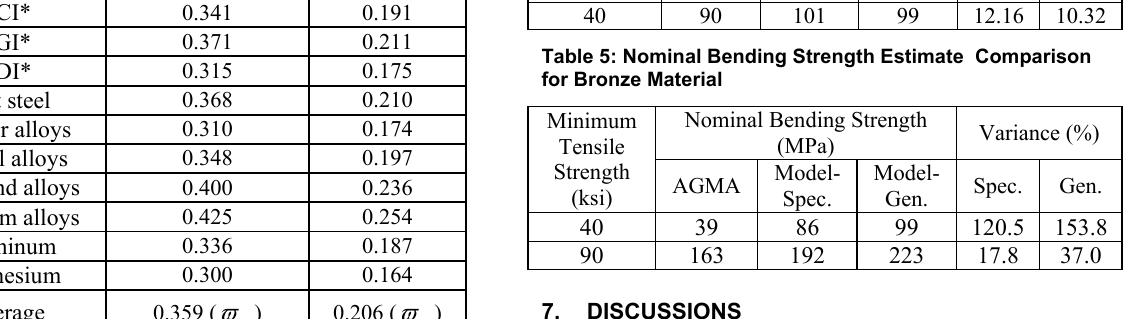
Table 1: Fatigue Ratios of Some Materials Material